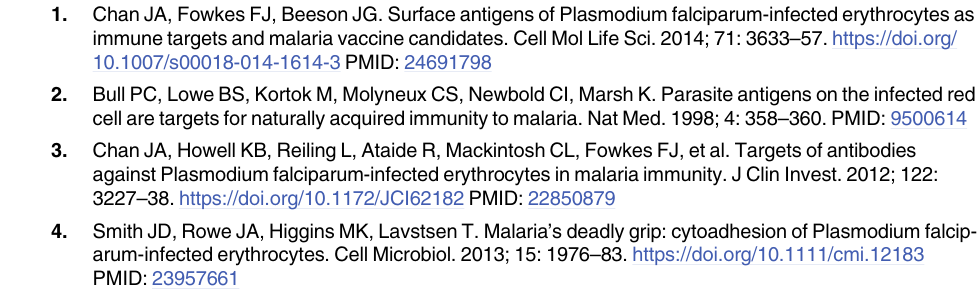
motif at the PoLV2 position (grey bar, Groups 2 and 5) which are highly concentrated in iso- lates causing severe disease (Serological Cluster II). Asterisks mark indicator antigens. Col- oured bars at the top of the figure indicate locations of homology blocks (see Fig 7 in main text). The horizontal black line indicates the DBL α sub-domain defined as S2b by Rask et al. (2010) with the arrowhead indicating that it extends beyond the window